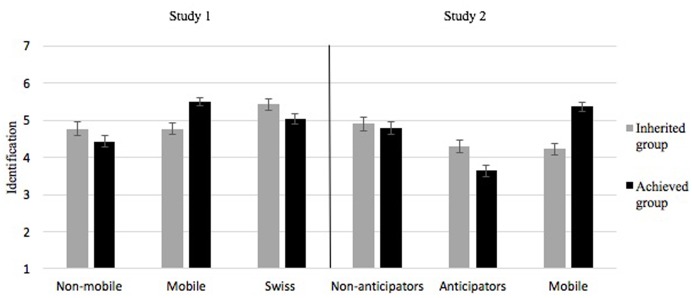
Means of inherited and achieved identification (Study I left, Study 2 right). Error bars indicate standard errors.